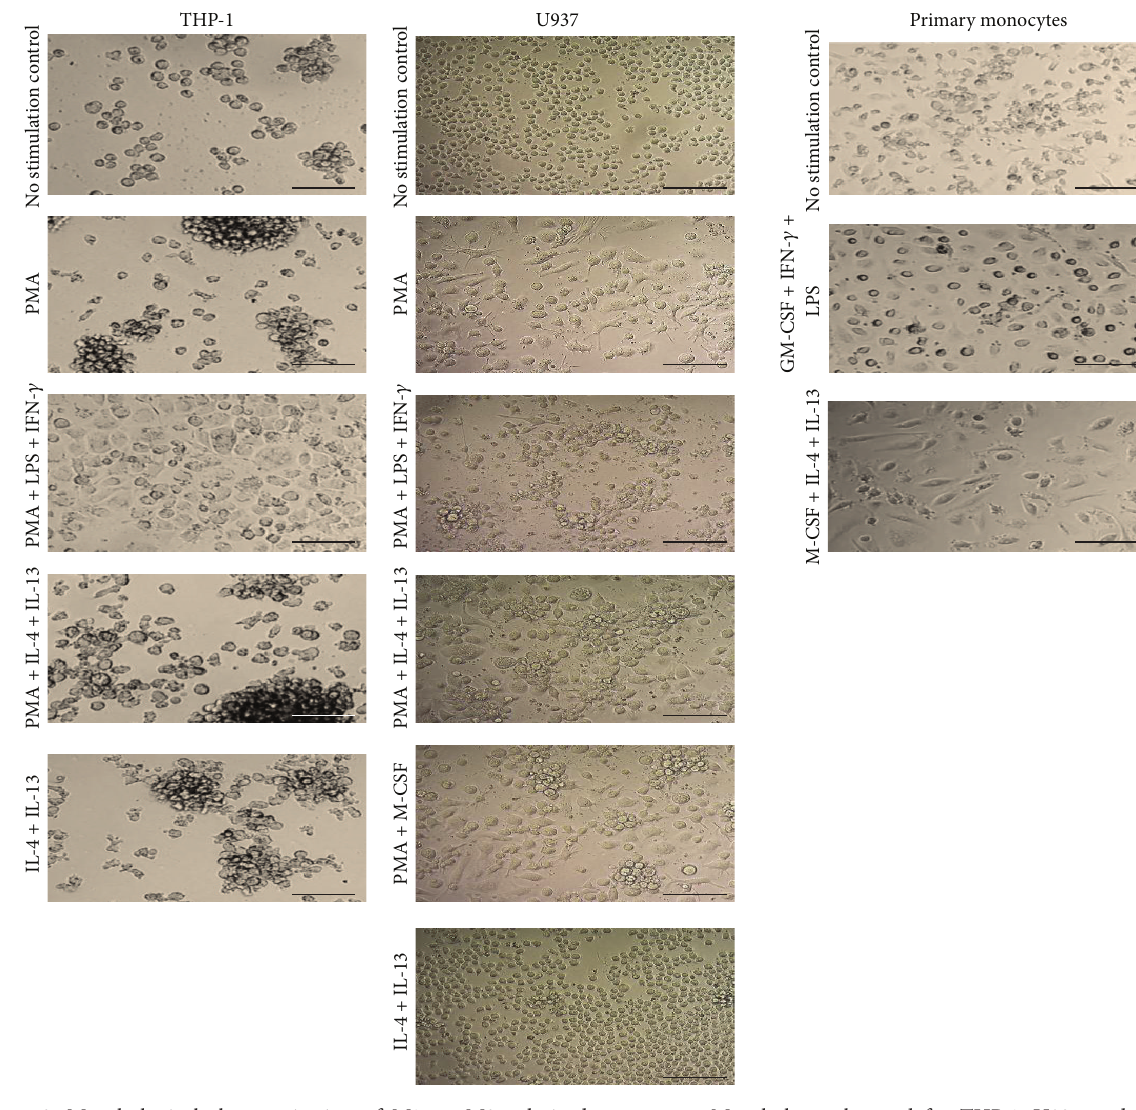
Figure 2: Morphological characterization of M1- or M2-polarized monocytes. Morphology observed for THP-1, U937, and primary monocytes under the indicated treatments. Images were taken with Motic Microscope at 200x magnification; scale bar indicates 50 𝜇 m. The most relevant features of differentiation were adherence, stronger in M1-polarizing treatments, and several cell shape changes in most cases presenting mixed shapes (round and spindle-like and with several membrane projections) and cell